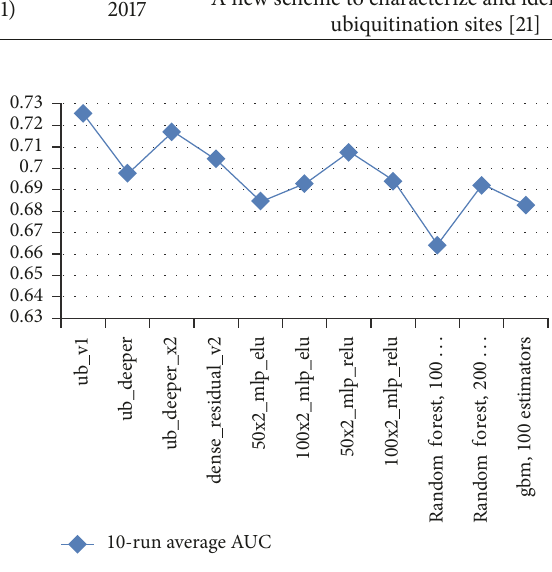
Figure 4: 10-run average AUC.